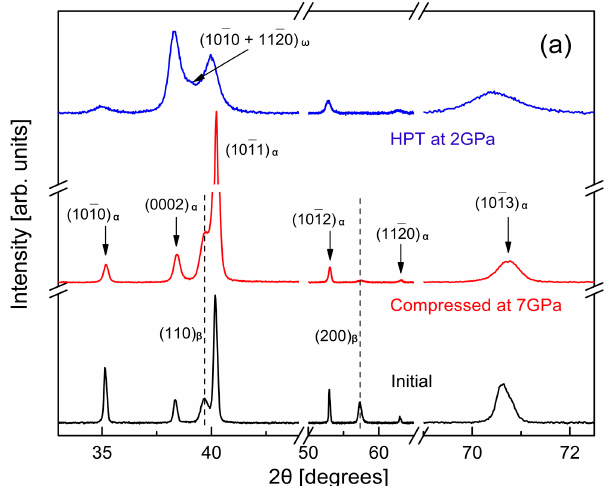
expense of α -phase.